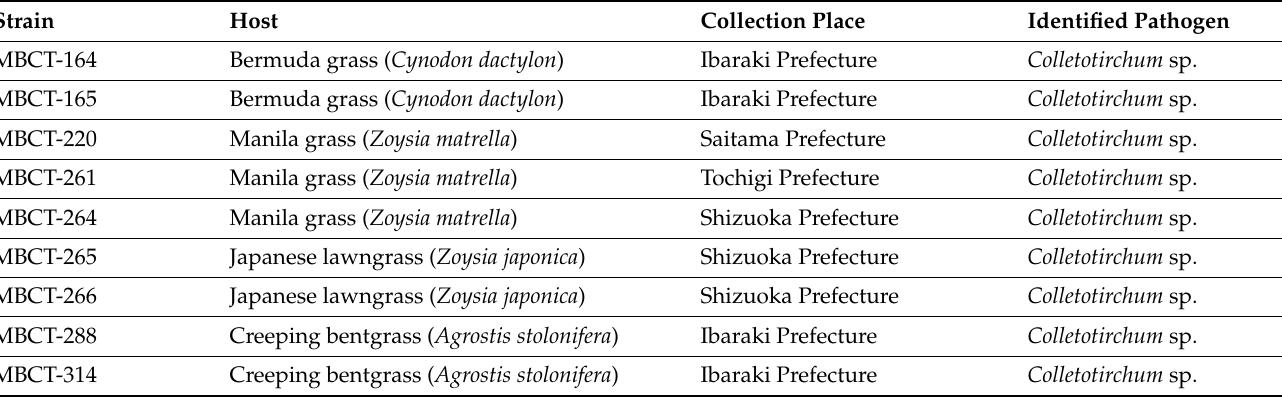
Table 1. Colletotrichum isolates used for dsRNA isolation in this